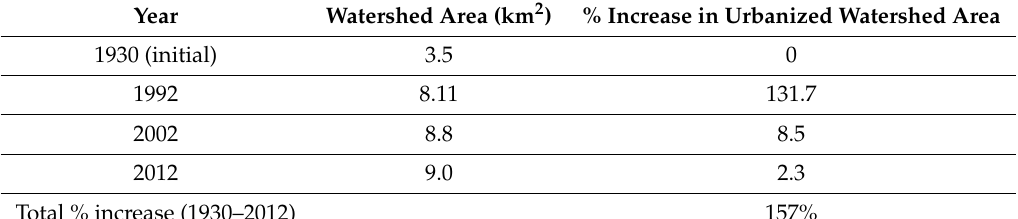
Table 1. Summary table of total watershed area, Total Impervious Area (TIA), and percentage of urbanized watershed area for 1930, 1992, 2002, and